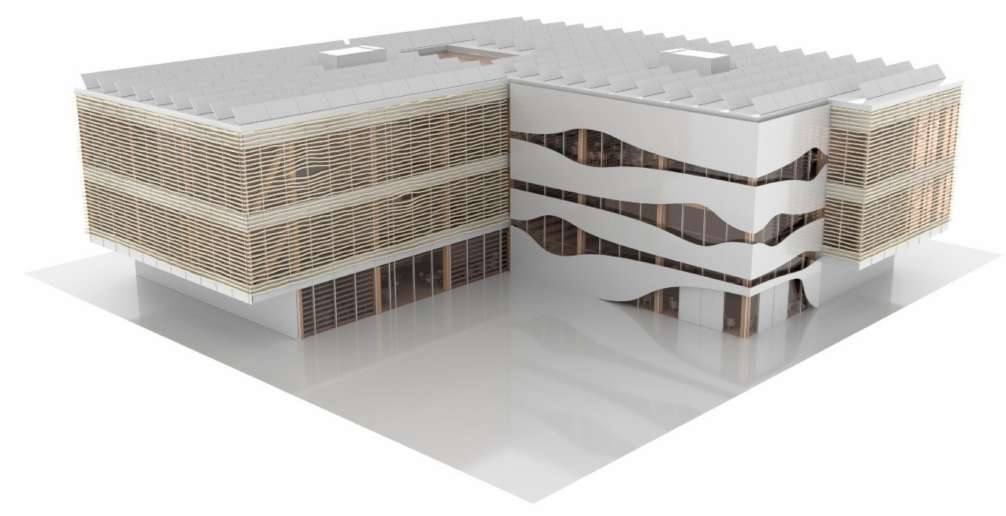
Figure 13. Render of the shading elements integrated into the building design.